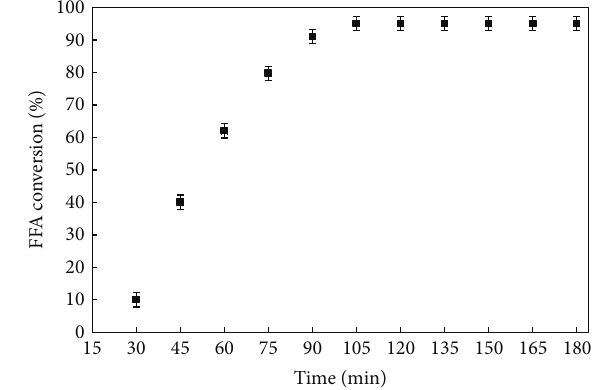
Figure 11: Conversion of FFA versus reaction time. The reac- tion conditions were 12 :1 methanol/CCO molar ratio, 3.6 wt% DSIMHSO 4 , 150 ∘ C, and 600